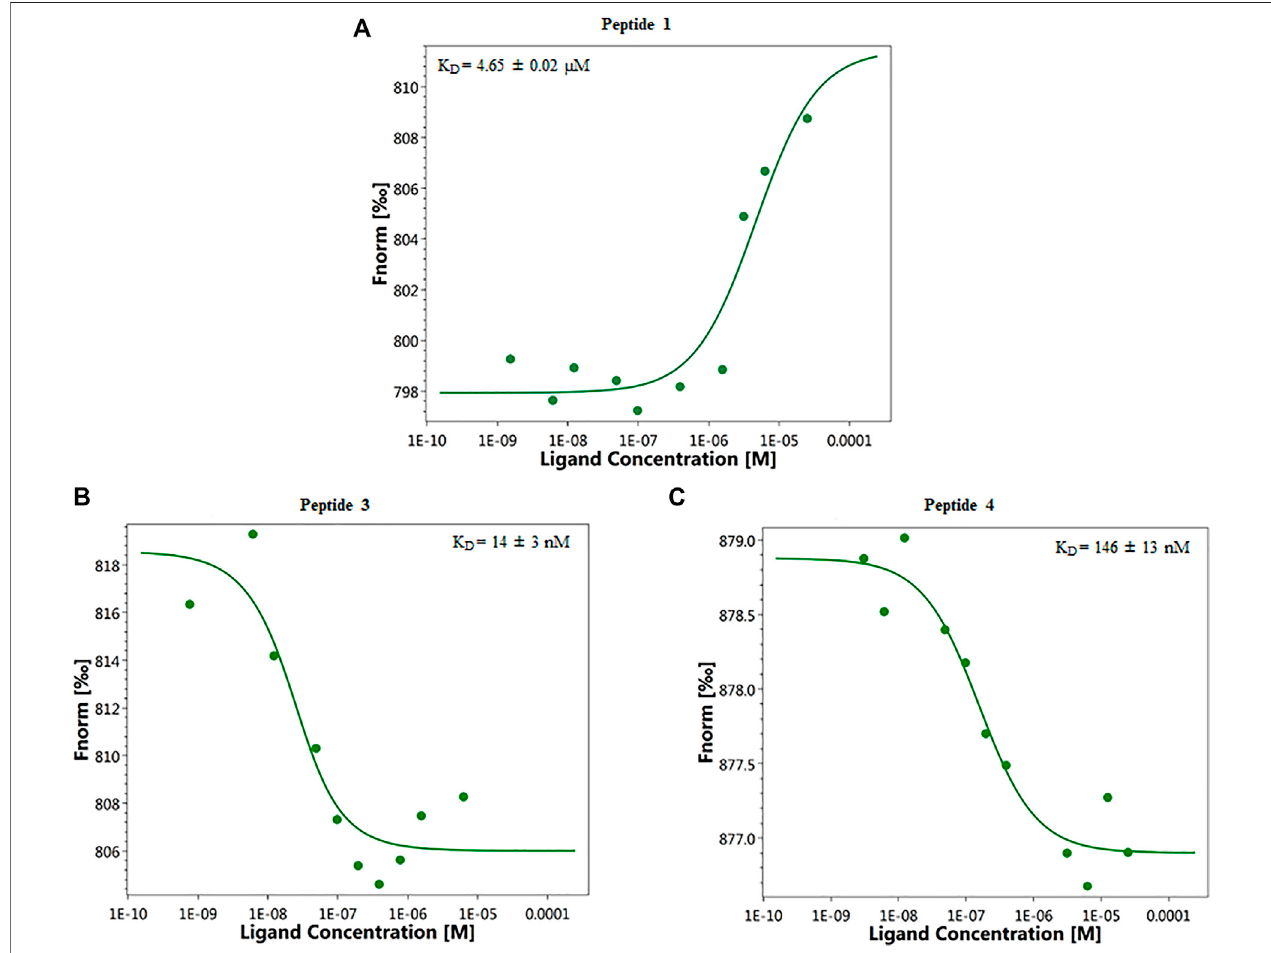
FIGURE1| Representativesingledose − responsecurvesof 1(A) , 3(B), and 4(C) bindingtoANXA4areshown;F norm ,normalized fl uorescence.Experimentswere repeated independently two times. Reported K D is the mean ± SD of two independent experiments.